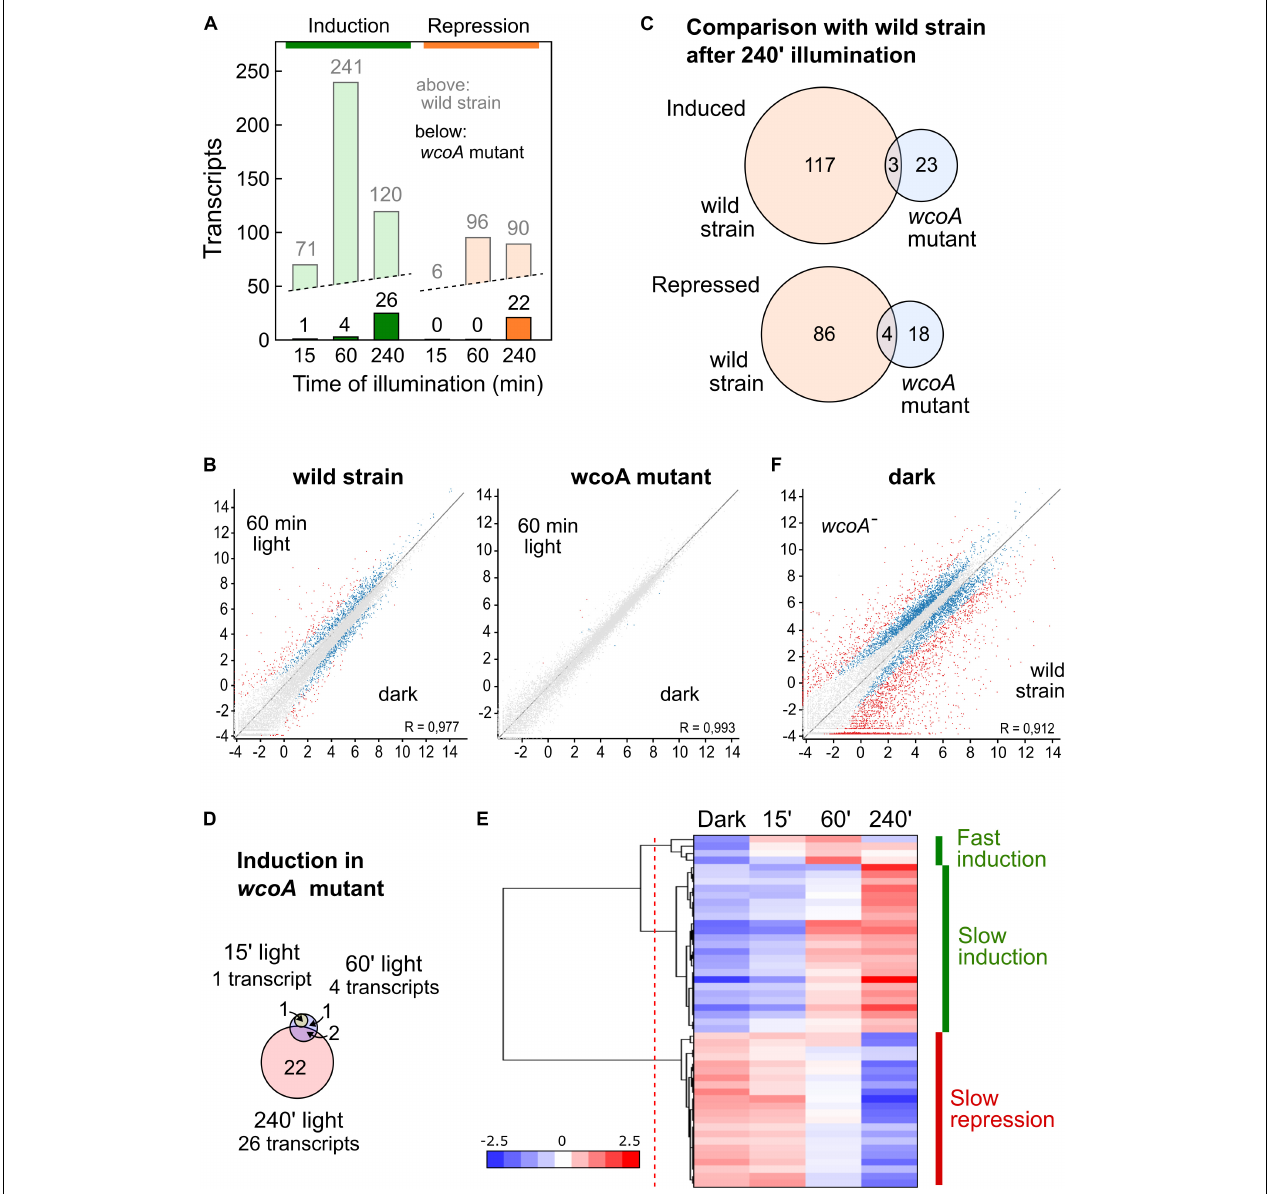
FIGURE 3 | Effect of illumination on the transcriptome of the wcoA mutant. (A) Numbers of genes upregulated (green) or downregulated (orange) after 15, 60, or 240 min illumination. For comparison, the data for the wild strain are shown in pale color. (B) Scatter plot representations (log2 rpm values) of the effect of 60 min illumination in the wild strain and in the wcoA mutant. Genes differentially expressed according to the Deseq analysis of the SeqMonk program are indicated in blue. Genes exceeding the log2 values of + – 2 are indicated in red. (C) Venn diagrams of the genes induced (above) or repressed (below) after 240 min illumination in the wild strain and in the wcoA mutant. The intersection shows the number of genes induced or repressed in both strains. (D) Venn diagrams of the genes induced in the wcoA mutant after the indicated illumination time. (E) Hierarchical heatmap of the genes induced or repressed in the wcoA mutant under the indicated illumination times. (F) Scatter plot representation of the effect of the wcoA mutation in the dark. Details as described in (B)